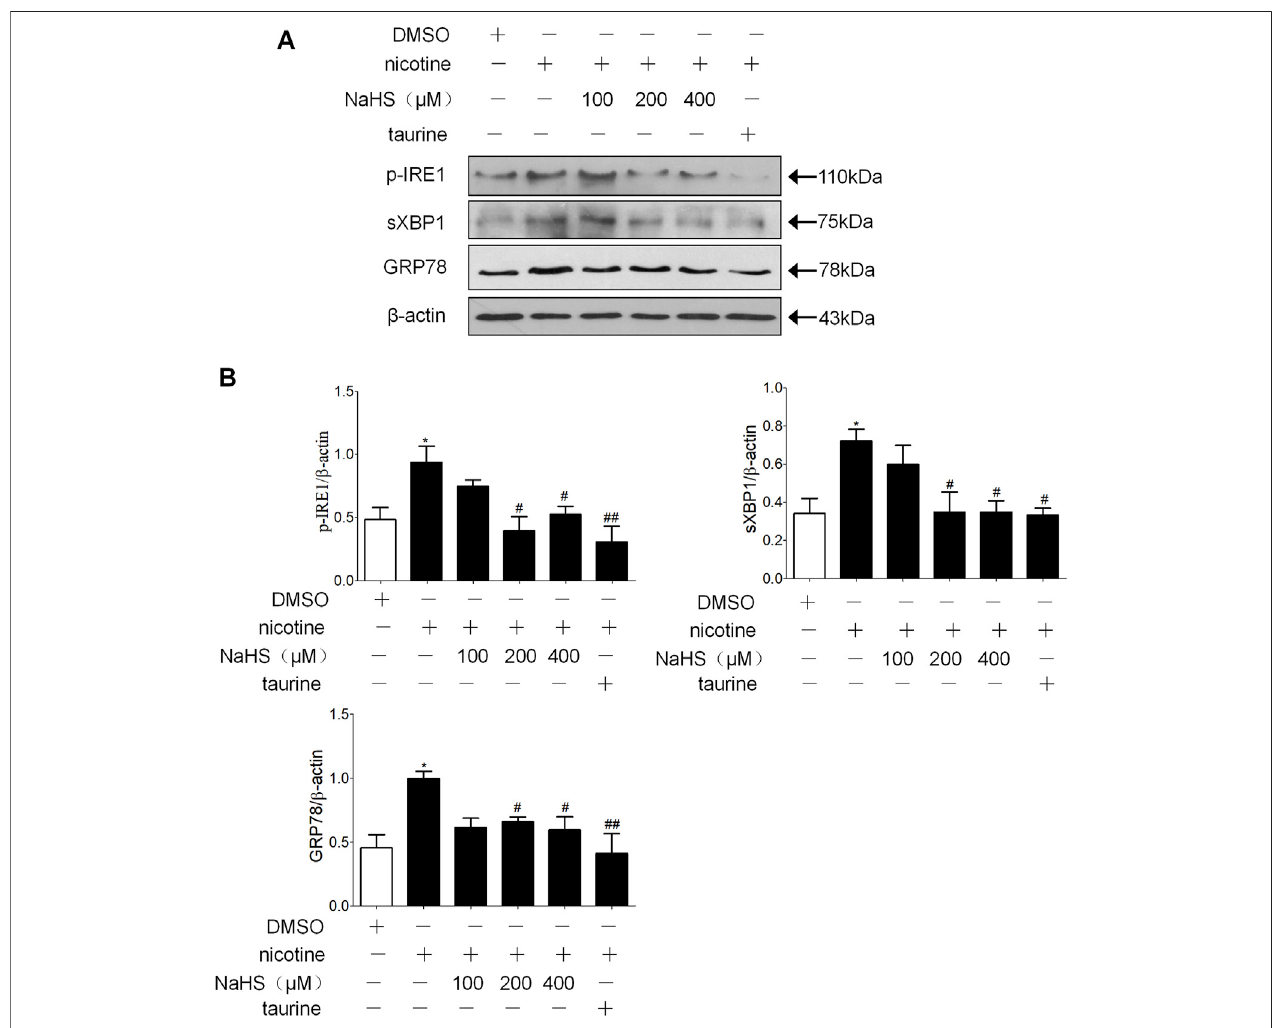
FIGURE 4 | H 2 S and ER stress inhibitor taurine suppressed nicotine-induced ER stress in 16 HBE cells. (A,B) Nicotine (40 μ mol/L) was used. Western blotting analysis of ER stress markers p-IRE1, sec-XBP1, and GRP78 protein expression in 16HBE cells, and relative intensity normalized to the expression of β -actin ( n = 3, respectively, in each group). Values are expressed as mean ± SEM. * p < 0.05 vs. the DMSO group. # p < 0.05, ## p < 0.01 vs. nicotine